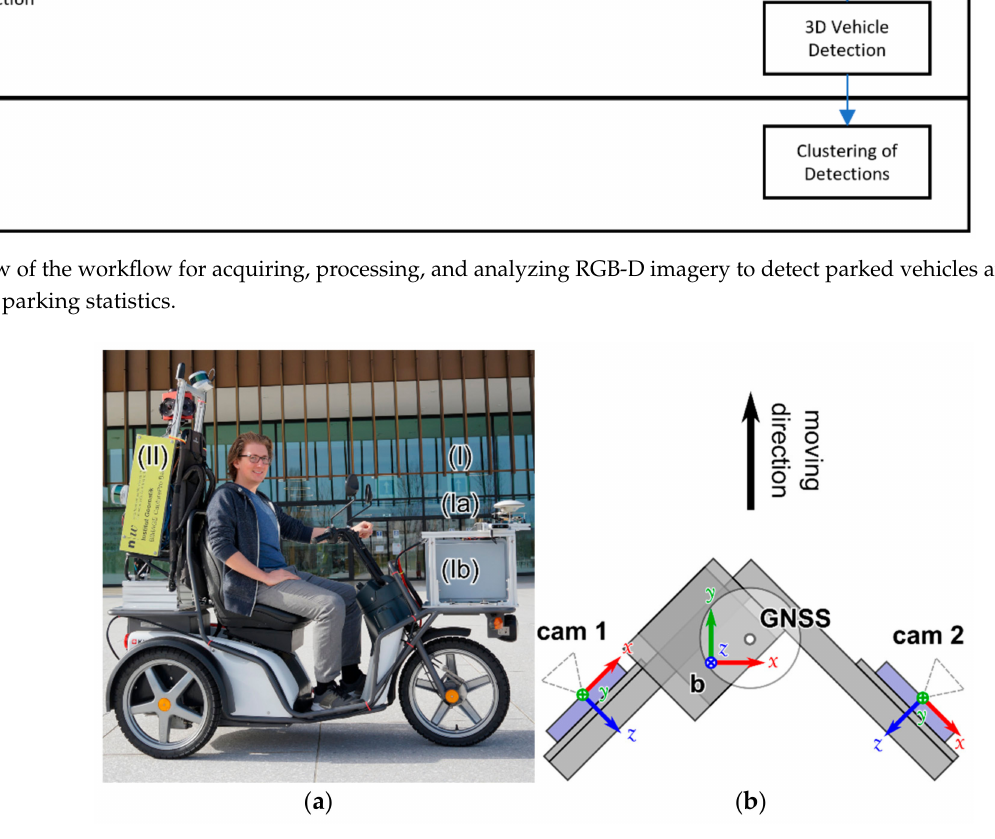
Figure 2. ( a ) Electrical tricycle mobile mapping platform with the low-cost sensor setup, which is mounted on the front luggage carrier (I) with (Ia) multi-sensor frame and (Ib) computer for data registration. Our backpack MMS that is fixed on the back luggage carrier (II) was used as a reference system for our investigations. ( b ) Outline of our low-cost multi-sensor frame showing sensor coordinate frames as the body frame b, both RealSense coordinate frames cam 1 and 2, and the GNSS L1 phase center GNSS. View frusta are indicated with dashed